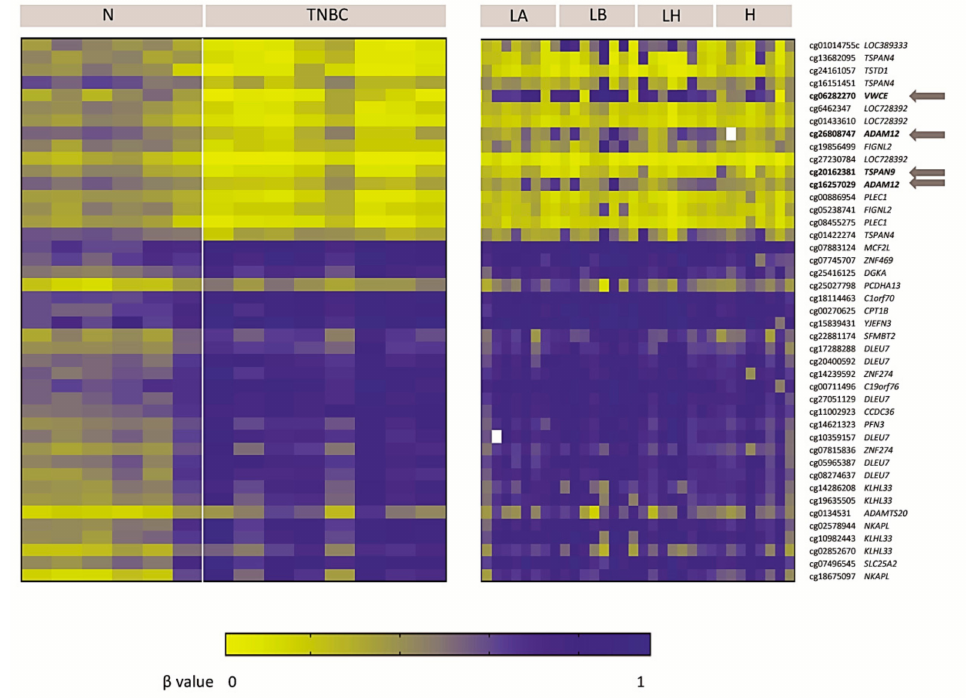
Figure 1. DNA methylome of triple-negative breast cancer (TNBC). Heat-map showing di ff erentially methylated probes in the 5 (cid:48) UTR region, at 1500–200 bp from the transcription start site or in the first exon (False Discovery Rate (FDR) < 0.05; ∆ β > 0.2) and their corresponding genes in TNBC tissues compared with non-neoplastic breast tissues (N), and other BC subtypes (Luminal A (LA), Luminal B / human epidermal growth factor 2 receptor (HER2)-negative (LB), Luminal B / HER2-positive (LH), and HER2-positive (H)). Genes with altered methylation exclusively in TNBC, but not in other BC subtypes, are highlighted with an